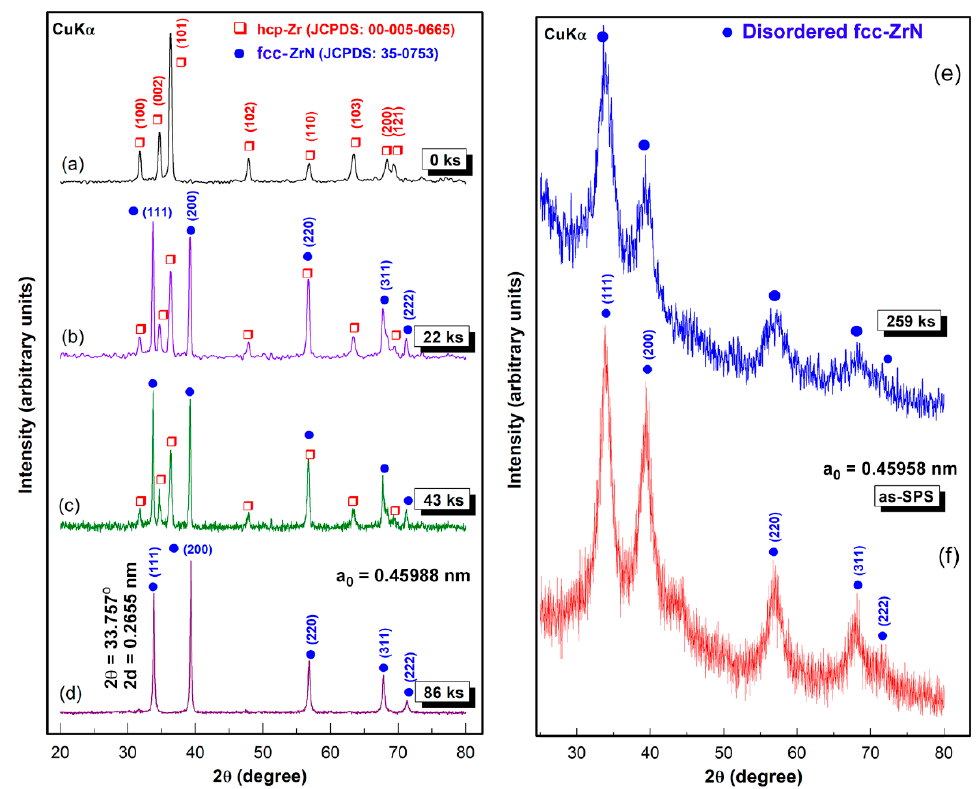
Figure 1. X-ray di ff raction (XRD) patterns of hcp-Zr metallic powder that were high-energy ball-milled Figure 1. X-ray diffraction (XRD) patterns of hcp-Zr metallic powder that were high-energy ball- for ( a ) 0 ks; ( b ) 22 ks; ( c ) 43 ks; ( d ) 86 ks; and ( e ) 259 ks of the reactive ball milling (RBM) time, ( f ) XRD milled for ( a ) 0 ks, ( b ) 22 ks, ( c ) 43 ks, ( d ) 86 ks, and ( e ) 259 ks of the reactive ball milling (RBM) time, pattern of the spark plasma sintered (SPS) 259 ( f ) XRD pattern of the spark plasma sintered (SPS) 259 ks-powders.